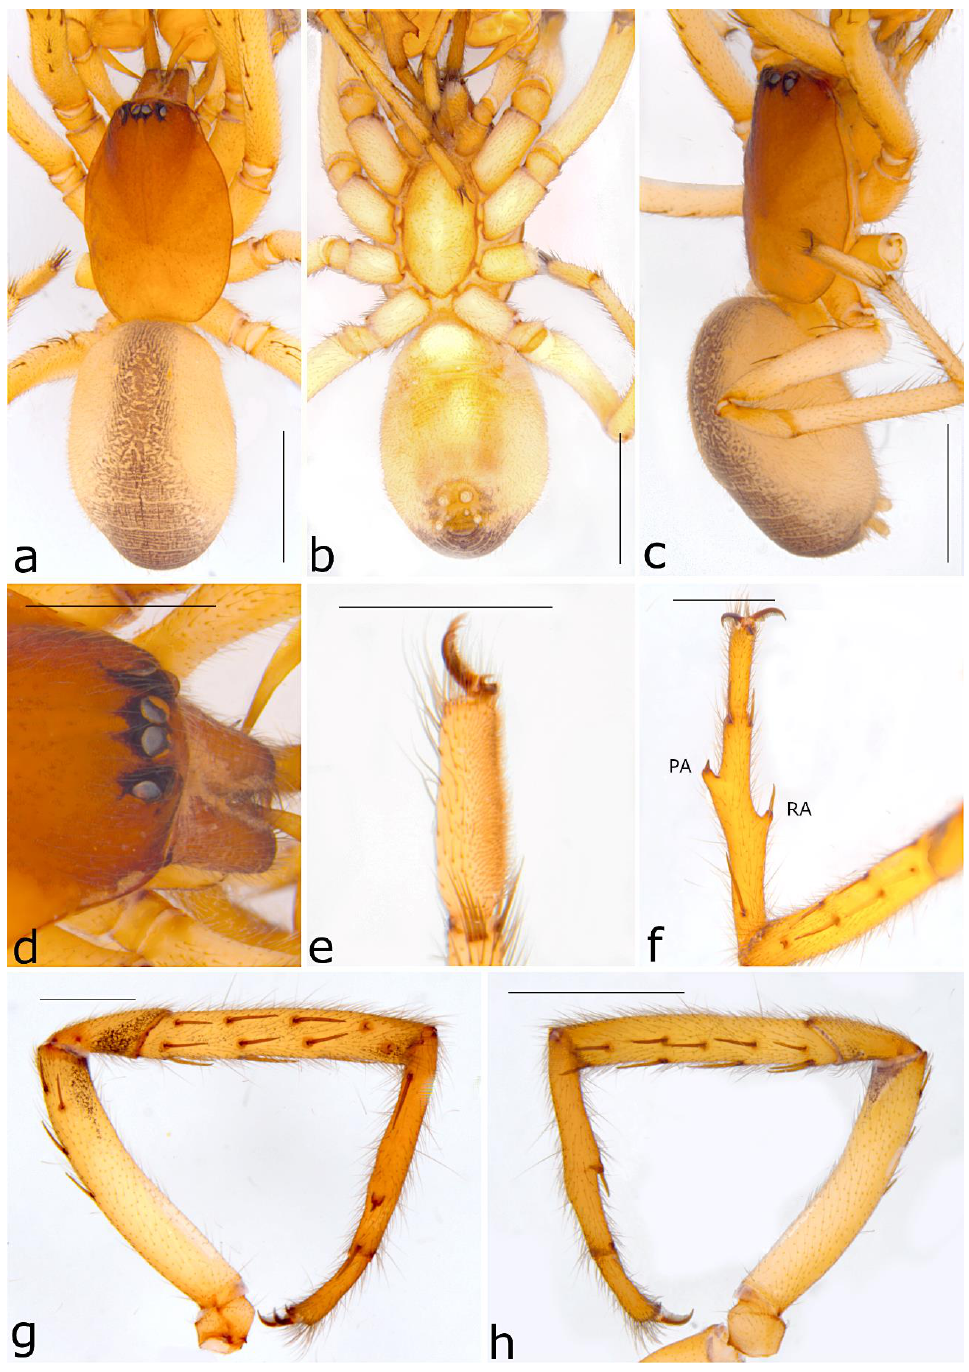
Figure 44. Ariadna pollex sp. nov. ♂ holotype (SAMA NN30485) from Purni Bore (SA): ( a ) habitus, dorsal view; ( b ) same, ventral view; ( c ) same, lateral view; ( d ) eyes, dorsal view; ( e ) left metatarsus IV, preening comb, retrolateral view; ( f ) left leg I, ventral view; ( g ) same, prolateral view; ( h ) same, retrolateral view. Scale bars ( a – c ) = 2 mm, ( d , e ) = 1 mm, ( f , g ) = 1 mm and ( h ) = 2 mm. Legs: Leg length ratio I > IV > II > III. Leg I total 10.8: femur 3.3, patella 1.3, tibia 2.9, metatarsus 2.4, tarsus 0.9. Leg II 9.8: 3.0, 1.0, 2.6, 2.3, 0.9. Leg III 8.6: 2.8, 1.0, 2.0, 1.8, 1.0.